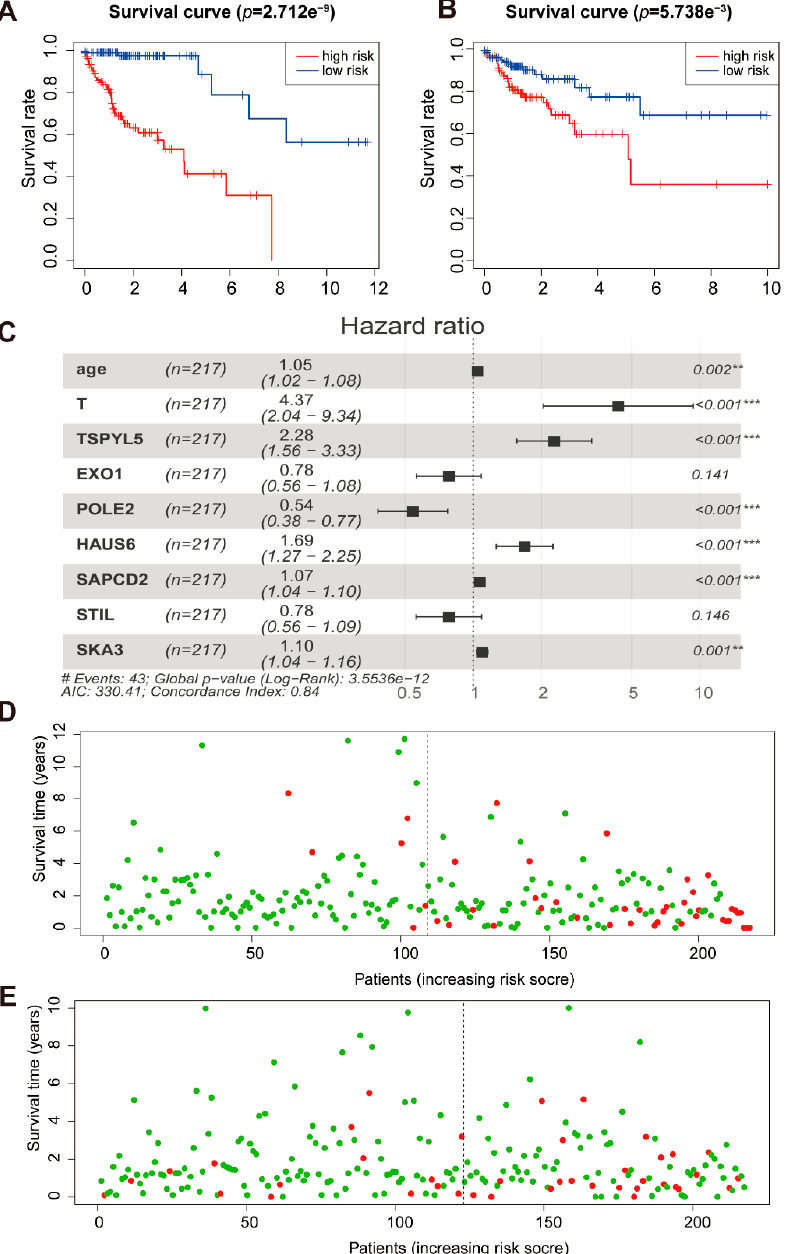
Figure 5. Cox regression model results in TCGA. ( A ) The survival curves for the m6A risk score in the training set. Grouping was based on the median m6A risk score in the training set. Red is the high-level group, and blue is the low-level group. ( B ) The survival curves for the m6A risk score in the test set. Red is the high-level group, and blue is the low-level group. Grouping was based on the median m6A risk score in the training set. ( C ) A forest plot of the multivariate Cox regression model. Hazard ratio is provided in the figure. ** p < 0.01, *** p < 0.001. ( D ) Patient survival status in the training set. The x-axis is the patient ranking in ascending order by m6A risk score; the y-axis is survival time. The red dots are the dead patients, and the green dots are the surviving patients. ( E ) Patient survival status in the test set. The x-axis is the patient ranking in ascending order by m6A risk score; the y-axis is survival time. The red dots are the dead patients, and the green dots are the surviving